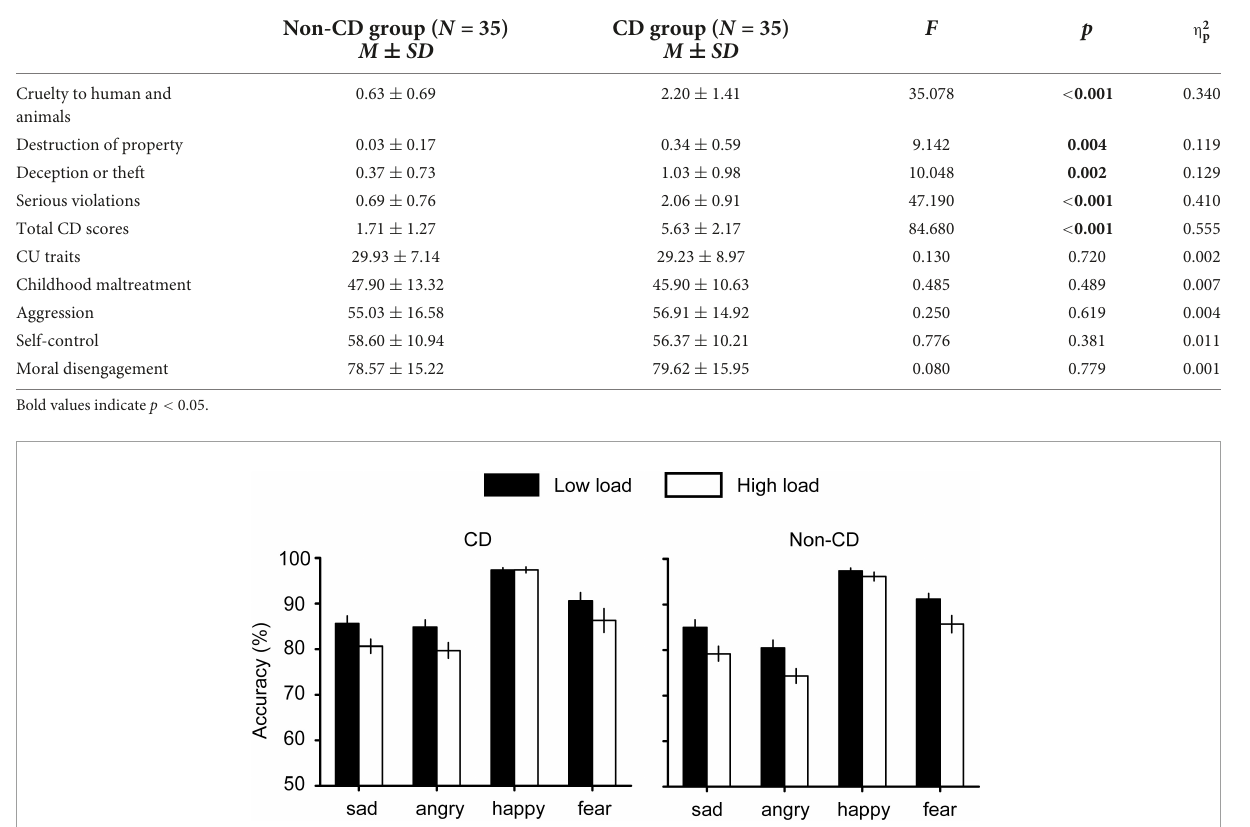
TABLE 1 Scale scores in conduct disorder (CD) group and non-CD group.